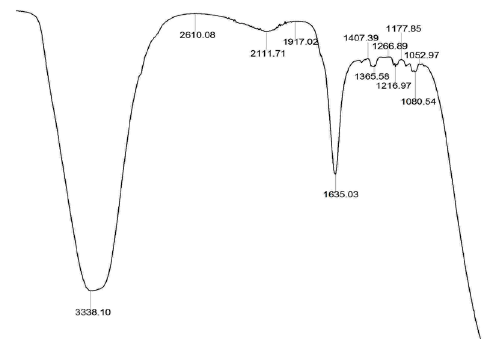
Fig. 6. FT/IR spectra of biodegraded used engine oil by formulated bacterial consortium adsorbed